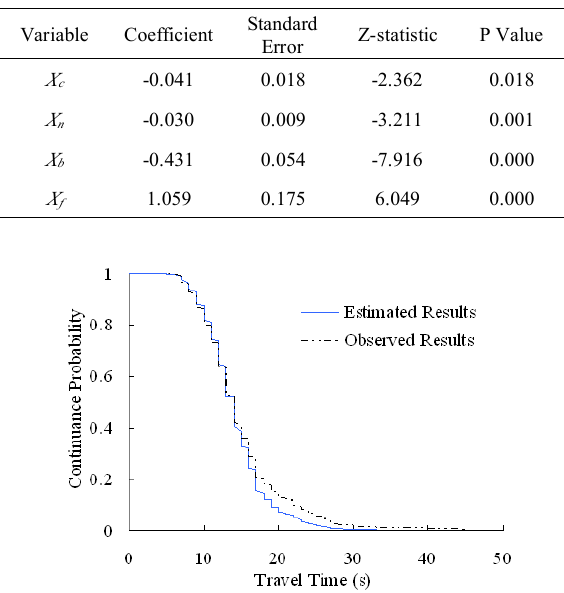
Fig. 2. Observed continuance probability and estimated continuance